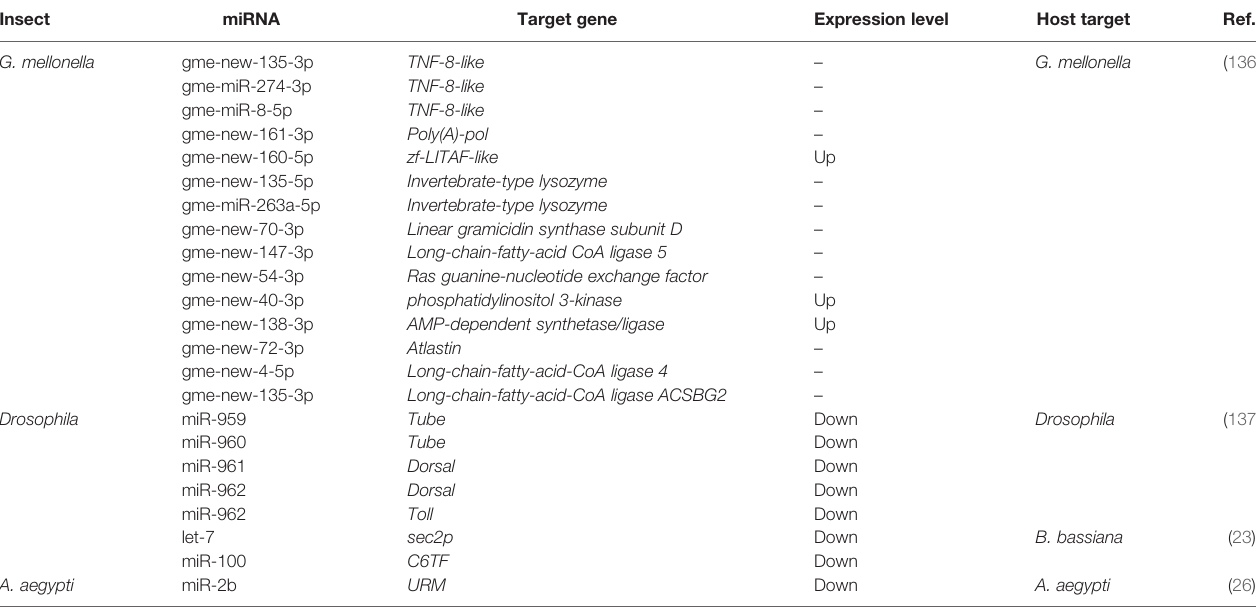
TABLE 1 | Novel and conserved insect-derived miRNAs and their immune targets.